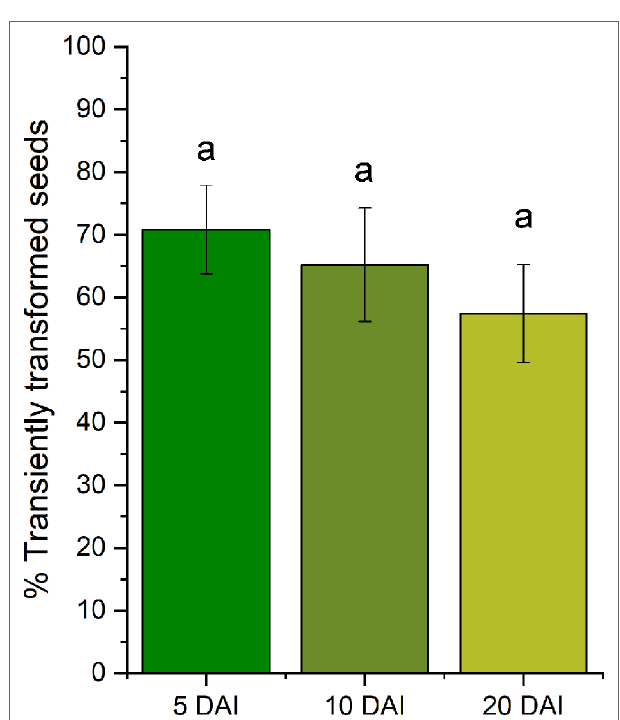
FIGURE 2 | Survival rates of transformed seeds when they were injected at 40 days after pollination (DAP) and the data were obtained 5, 10, and 20 days after injection (DAI). Data represents the average of the survival rates of 4 groups of seeds injected the same day. The size of these groups were of 20 seeds for 5 DAI (20 × 4 = 80 total seeds), 18 seeds for 10 DAI (18 × 4 = 72 total seeds) and 19 seeds for 20 DAI (19 × 4 = 76 total seeds). Letters indicate statistically significant differences (one-way ANOVA 0.05% significance